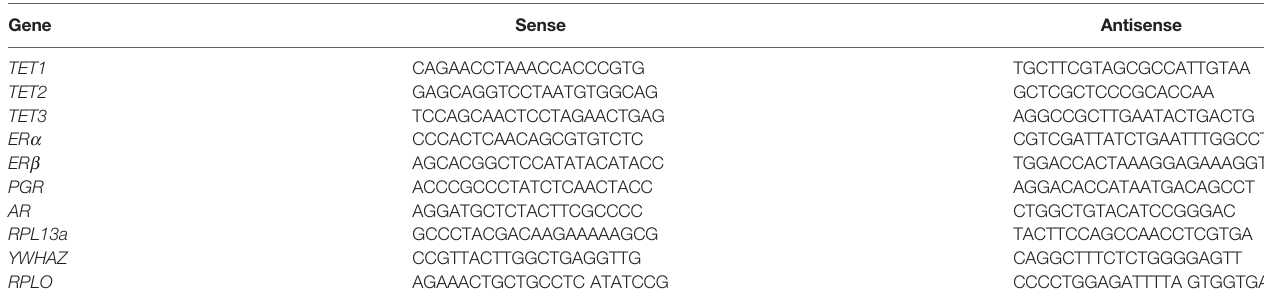
TABLE 1 | Primer Sequences used for